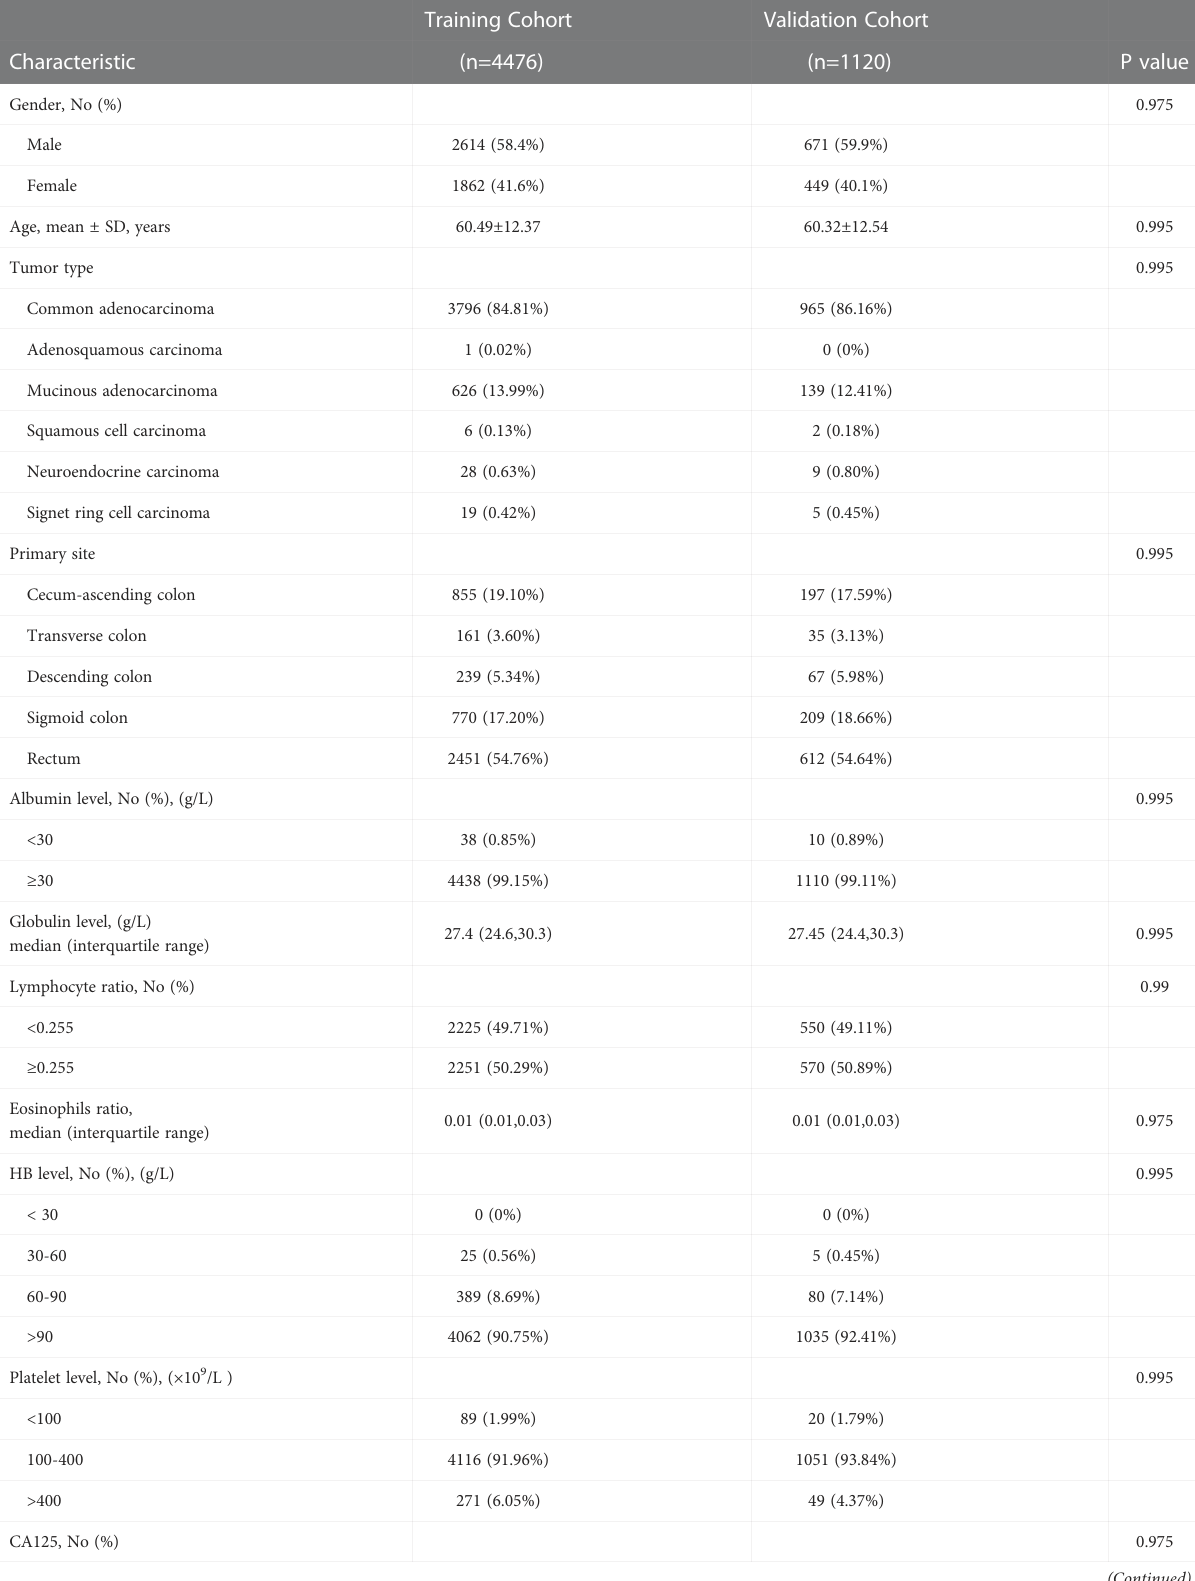
TABLE 1 Characteristics of patients in the training and validation